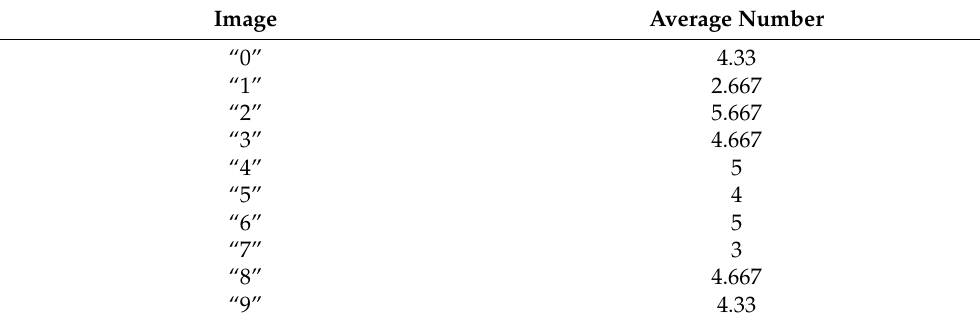
Table 1. Average Number of